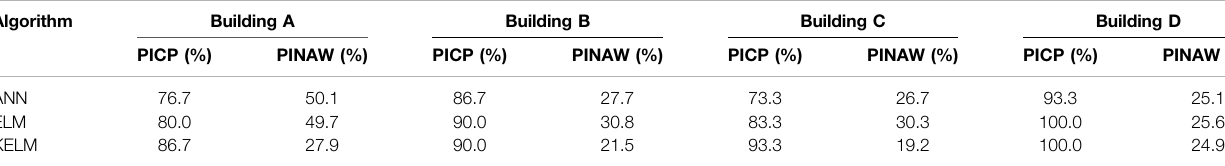
TABLE 3 | PICP and PINAW of ANN, ELM, and KELM on the testing